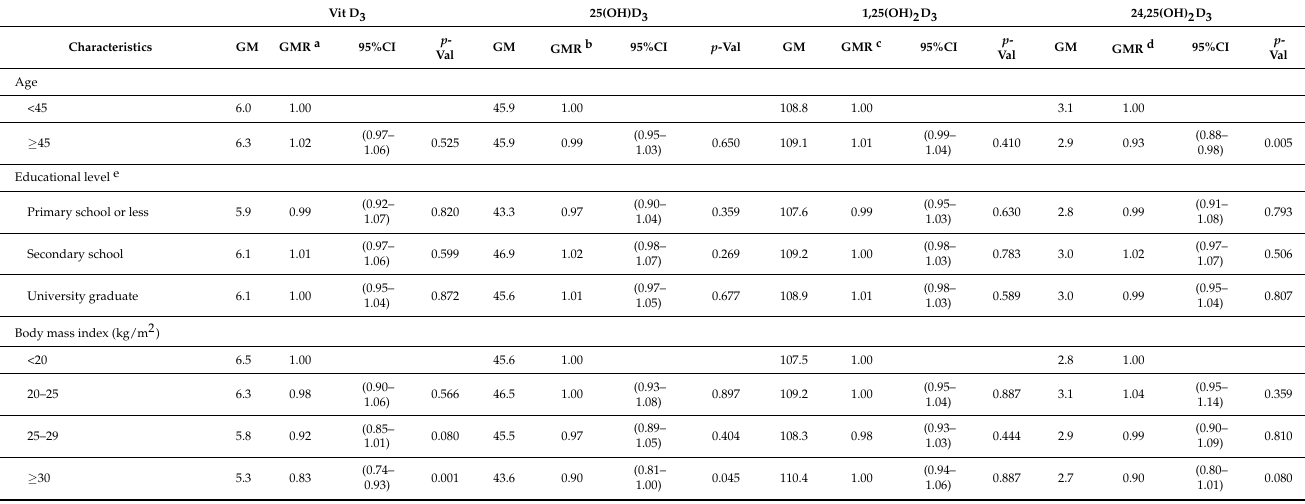
Table 2. Association between vitamin D metabolite concentrations and characteristics of